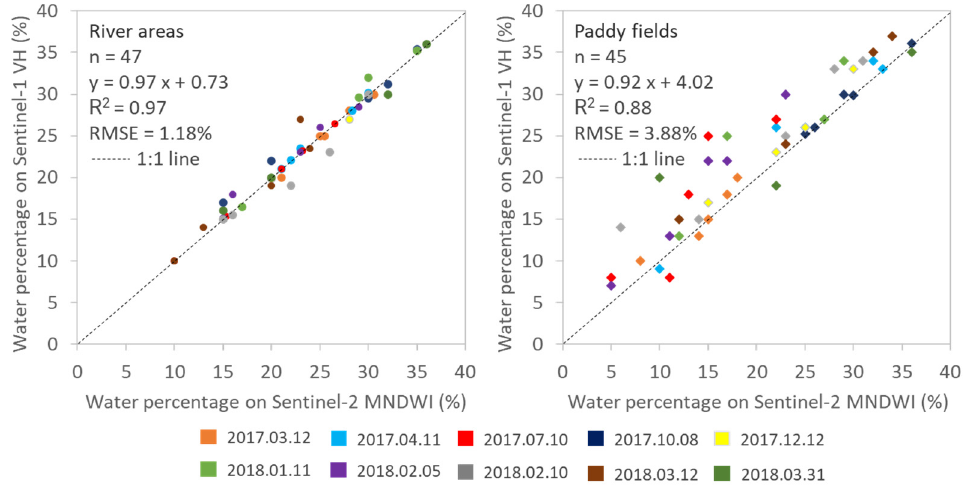
Figure 13. Statistical comparison of water delineation derived from the SAR Sentinel-1 VH images and the Sentinel-2 MNDWI images in the river areas ( left ) and paddy fields ( right ) .